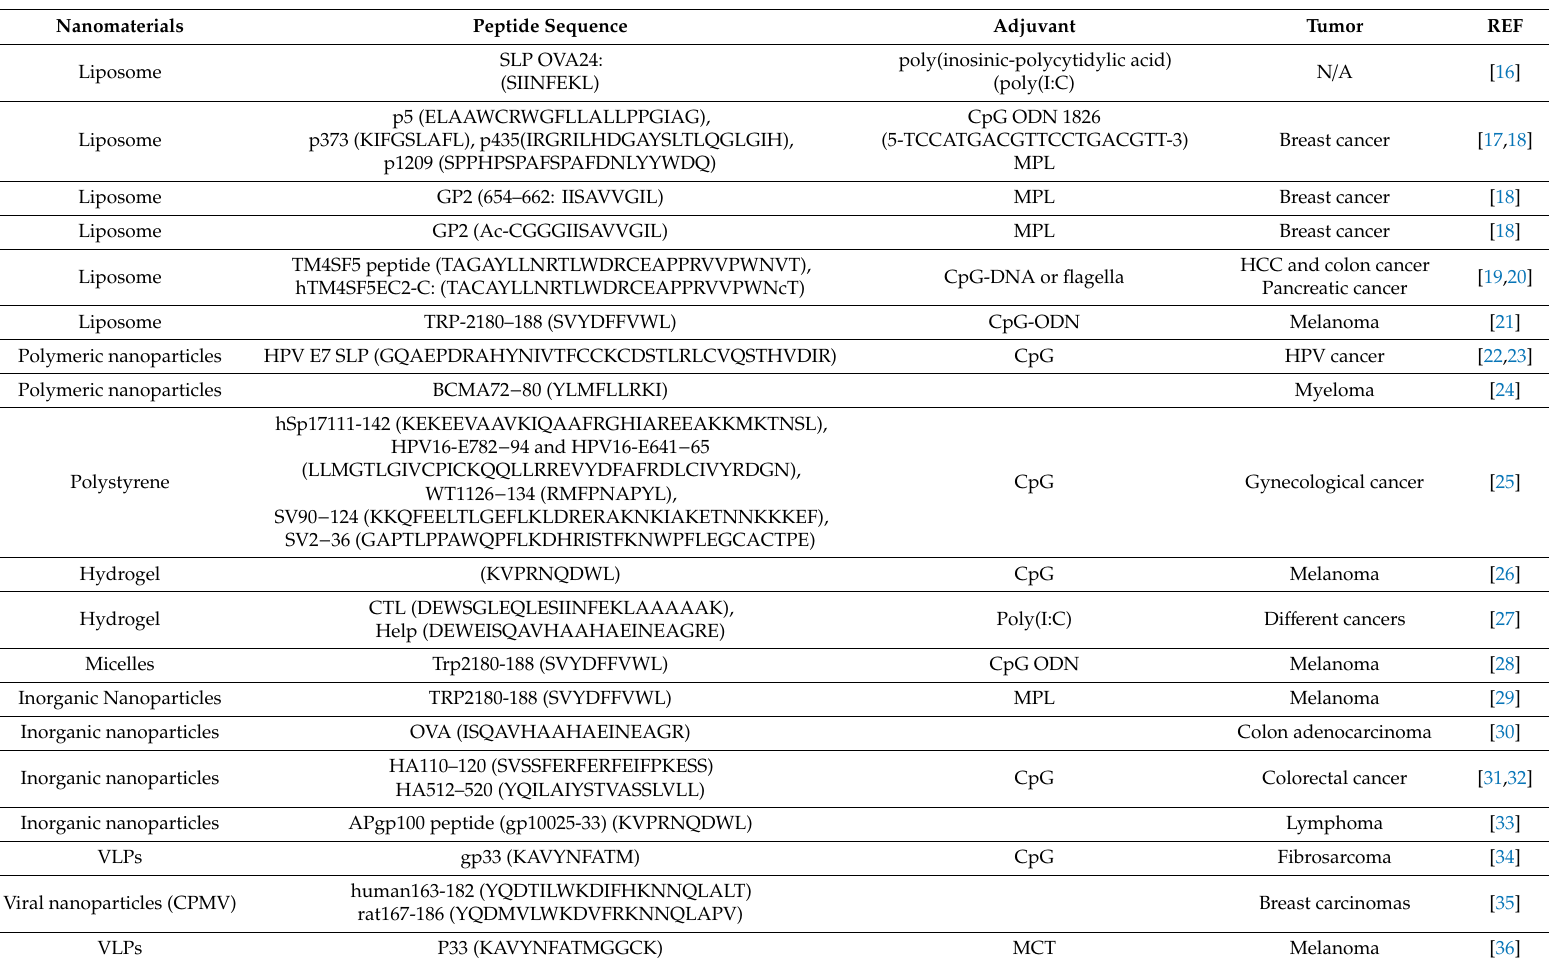
Table 1. Examples of nanoparticles formulated with peptides and adjuvants as cancer vaccine